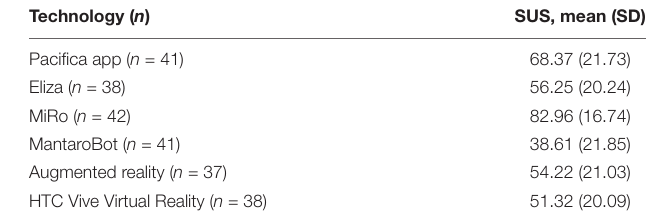
TABLE 3 | Mean (SD) for System Usability Scale measure.